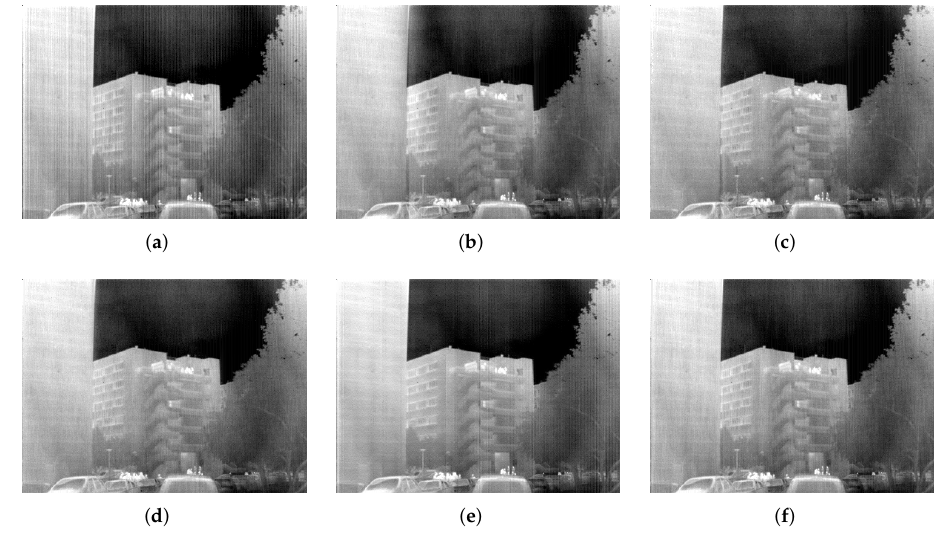
Figure 8. Stripe nonuniformity correction results for Building. ( a ) Raw; ( b ) WTSF; ( c ) MIRE; ( d ) GIF; ( e ) CNN; ( f )